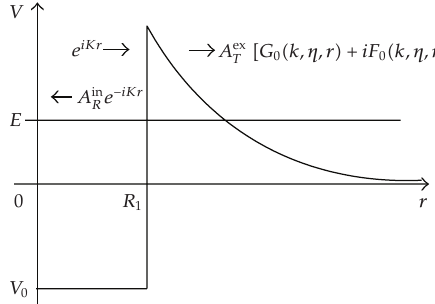
Figure 14: Schematic view of the emission from inside through a coulomb